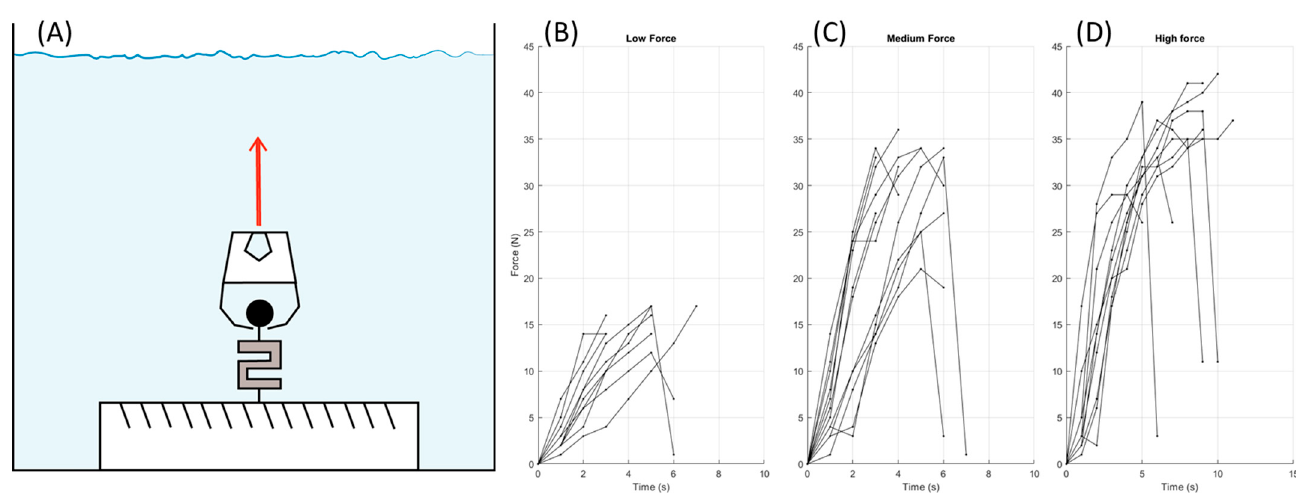
Figure 9. Experimental setup and results of pull-out tests. ( A ) Experimental setup. The gripper, holding a spherical object connected to a load cell on the bottom of the tank, is pulled with non- controlled velocity for three increasing values of pulley angle. ( B ) Results for the low force activation. ( C ) Results for the medium force activation. ( D ) Results for the high force activation.